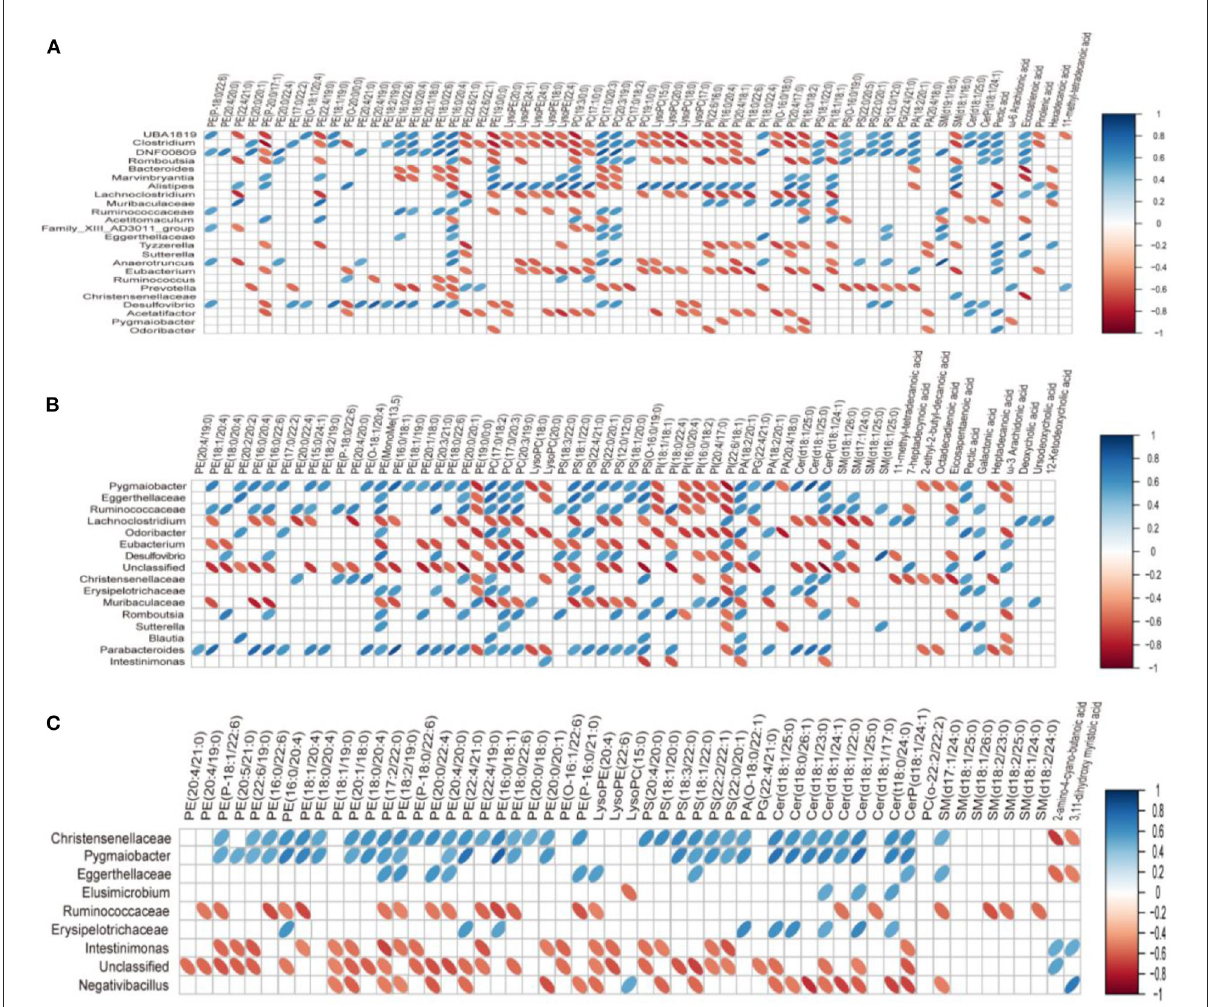
FIGURE8 Correlation between lipid metabolism and gut microbiota in serum. (A) BC group vs. HFD group, (B) LS group vs. HFD group, (C) LS + BC group vs. HFD group. On the top of the graph is the name of metabolite, and on the left side is the name of association gut microbiota. Blue for positive correlation and red for negative